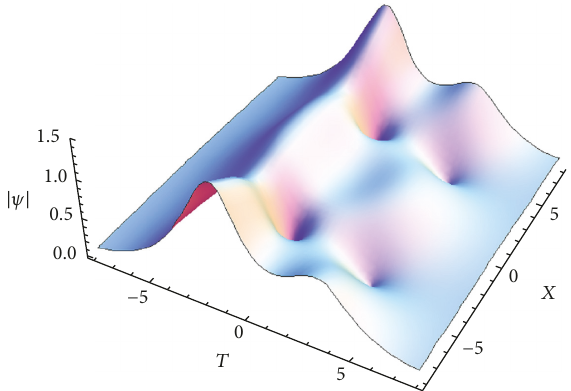
Figure 7: Spatial structure of the module of solution (62).